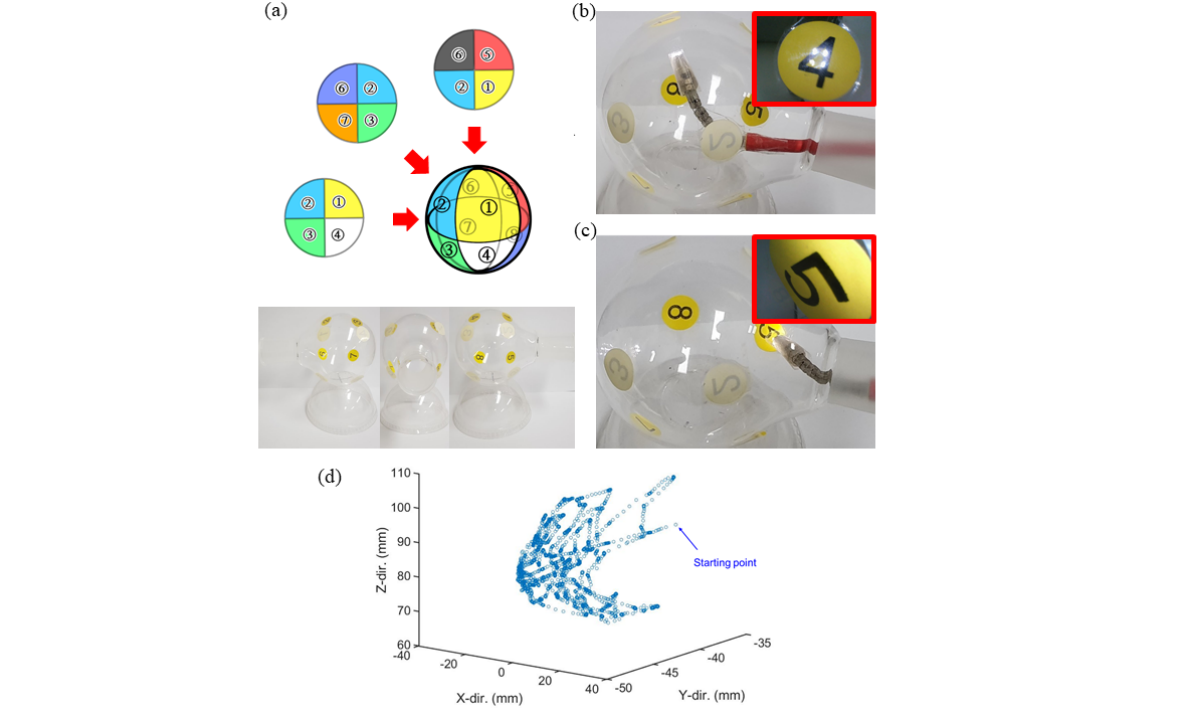
Figure 12. Spatial bending test of the continuum body: (a) test sphere divided into eight regions, (b) facing region ④ (inset: endoscopic view of region ④ ), (c) approaching region ⑤ (inset: endoscopic view of region ⑤ ), and (d) spatial trajectory of a